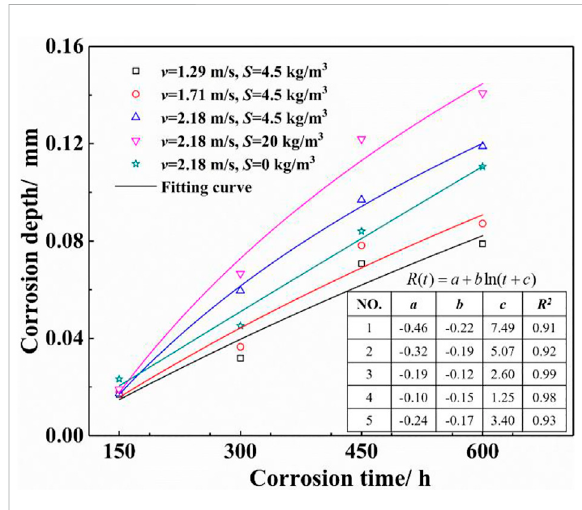
FIGURE 8 Fitted curves of steel corrosion depth with corrosion